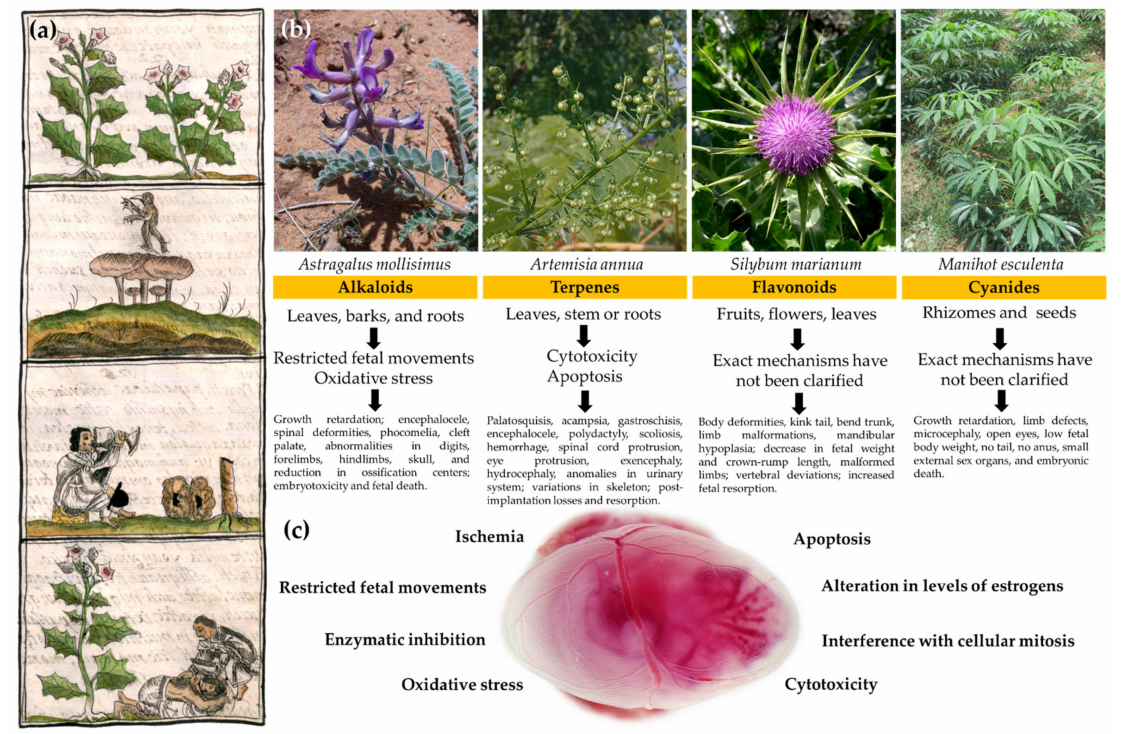
Figure 1. Developmental defects and the mechanisms of teratogenicity of the main compounds identified in Mexican plants. ( a ) In the upper part, this fragment of the Florentino codex shows the importance of the role that plants played in the pre-Hispanic Mexican culture (a reflection of the current one). Hallucinogenic plants, from top: tlapatl, nanacatl, peyotl, and tolo (bottom) used by the ancient indigenous people to stimulate the nervous system, for ritual or medicinal purposes as in love sickness [129]. ( b ) Four of the following teratogenic plants most used by the Mexican population as medicine or food are depicted: Astragalus mollissimus [130]; Artemisia annua [131]; Silybum marianum [132], and Manihot esculenta [133]. At the bottom of the fragment, we find the responsible compound, the part of the plant in which the compound predominates, the proposed mechanisms of teratogenicity, and the observed teratogenic effects. ( c ) A 12.5 GD mouse embryo is shown inside its amniotic sac to represent the teratogenic mechanisms identified in Mexican plants that can affect its development. Although the exact mechanisms have not been fully clarified, the authors suspect that the main mechanisms in the observed teratogenic effect are as follows: oxidative stress; ischemia; enzymatic inhibition; alteration in levels of estrogens; cytotoxicity; apoptosis; interference with cellular mitosis; restricted fetal movements, among others. It is noteworthy that such alterations can be produced not only by a single mechanism, but also by the interaction of several of